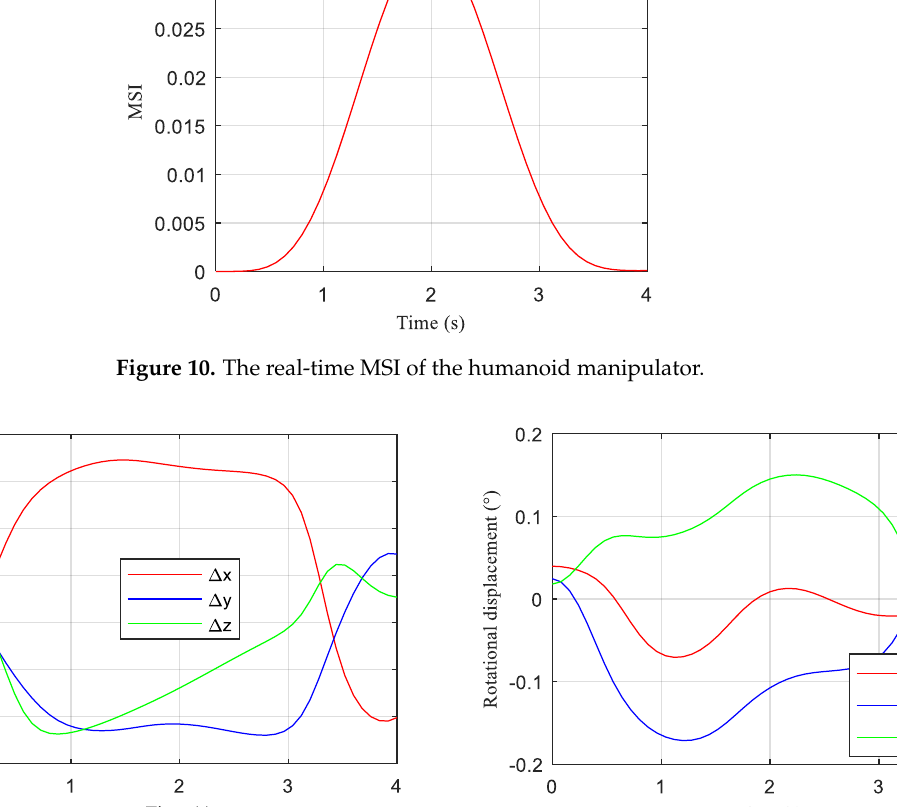
Figure 11. The generalized displacements of the end effector of the humanoid manipulator. ( a ) Real-time translational displacements of the end effector; ( b ) Real-time rotational displacements of the end effector.